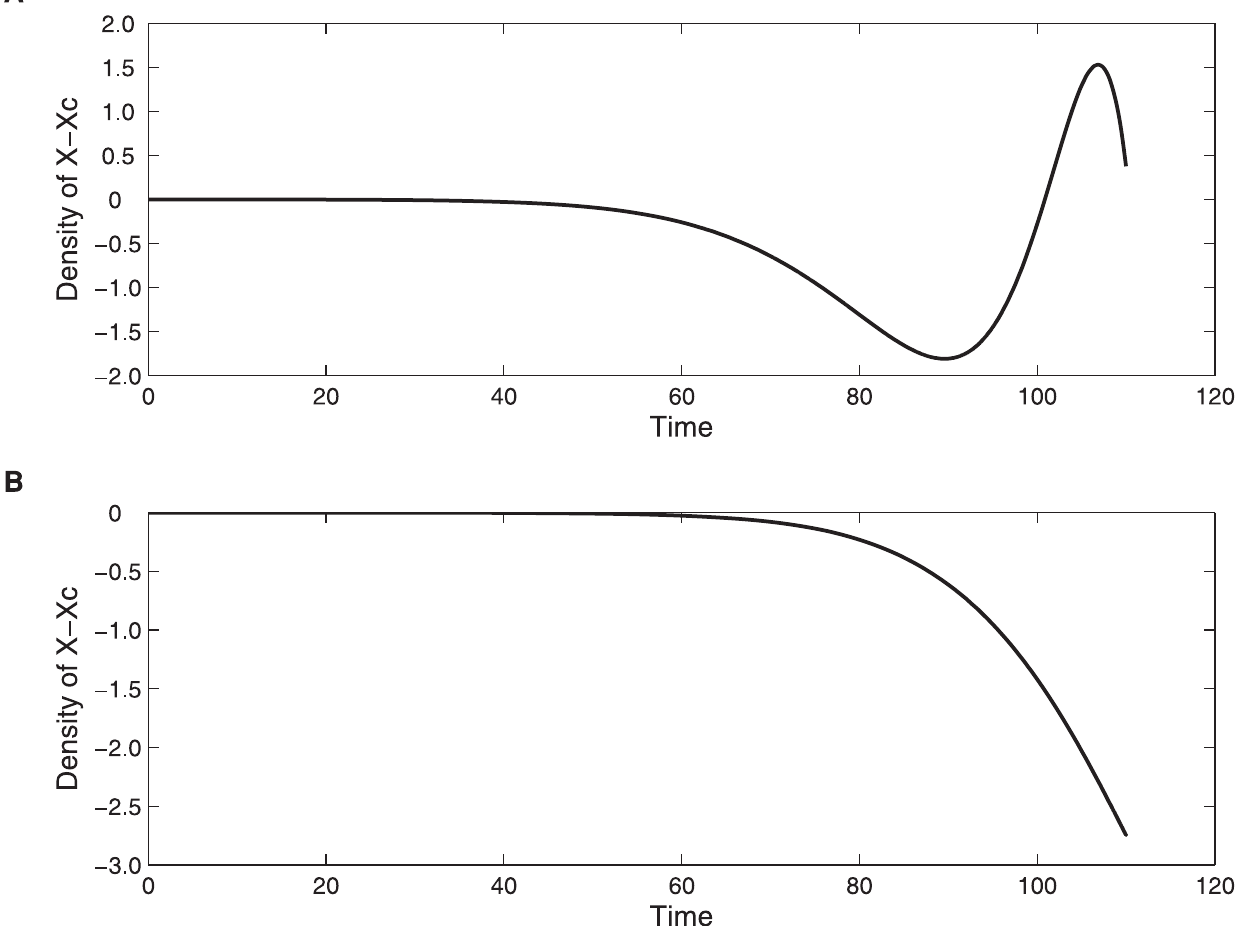
1 = e 2 =0.01; B . cross-